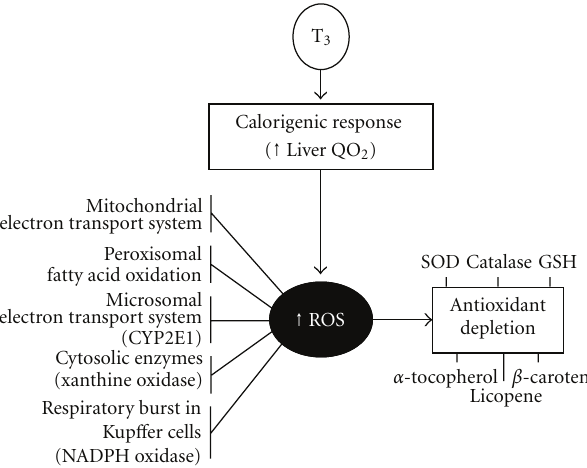
Figure 2: Calorigenic response of thyroid hormone (T 3 ) and its relationship with O 2 consumption, reactive oxygen species (ROS) generation, and antioxidant depletion in the liver. Abbreviations: CYP2E1, cytochrome P450 isoform 2E1; GSH, reduced glutathione; QO 2 , rate of O 2 consumption; SOD, superoxide